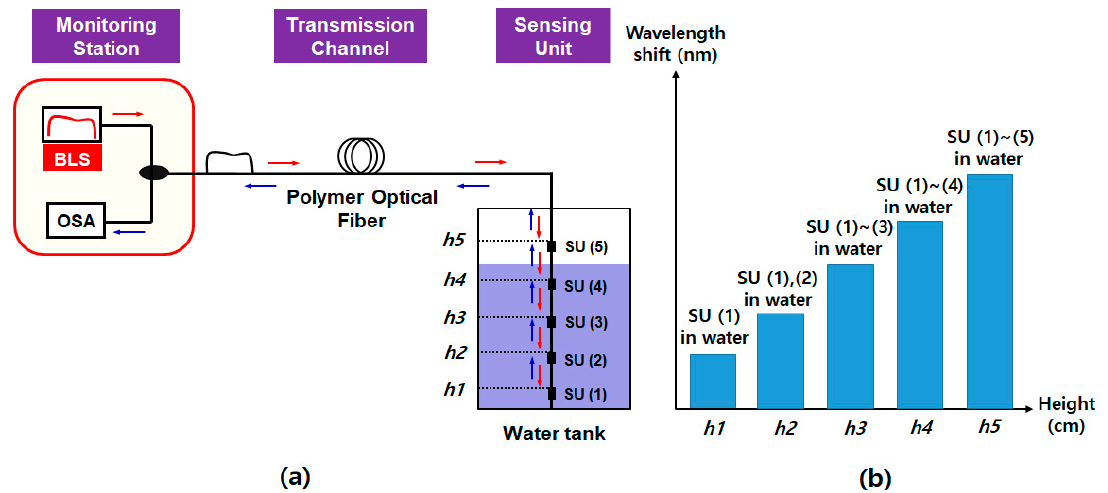
Figure 6. ( a ) Schematic diagram of the coarse wavelength division multiplexing (CWDM)-based water level monitoring system. ( b ) Conceptual interrogation results according to the water level. Adapted from Marques et al. [37]. BLS: broadband light source, OSA: optical spectrum analyzer, SU: sensing unit, and h 1– h 5: height of the water level where the SU are installed.